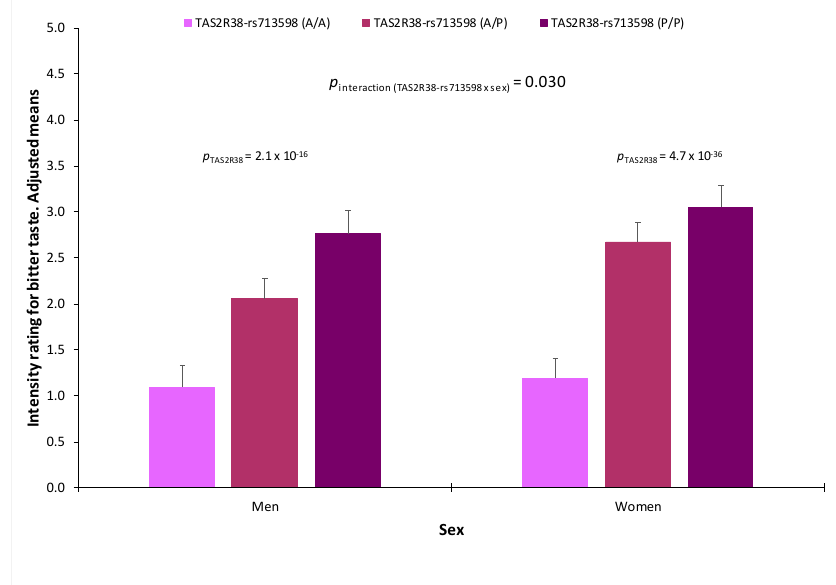
Figure 6. Bitter taste perception (intensity rating of PROP, 5.5 mM) in men ( n = 342) and women ( n = 603) by the TAS2R38 ‐ rs713598 polymorphism (men: n = 116 for Ala/Ala, n = 157 for Ala/Pro and n = 69 for Pro/Pro; women: n = 188 for Ala/Ala, n = 307 for Ala/Pro and n = 108 for Pro/Pro). Means were adjusted for sex, age, diabetes, body mass index, smoking and medications (model 3). p ‐ values show the statistical significance of the TAS2R38 ‐ rs713598 polymorphism stratified by sex, in the multivariate adjusted model 3. The p ‐ value for interaction term between the TAS2R38 ‐ rs713598 and sex was additionally tested in model 3. Error bars are SE.